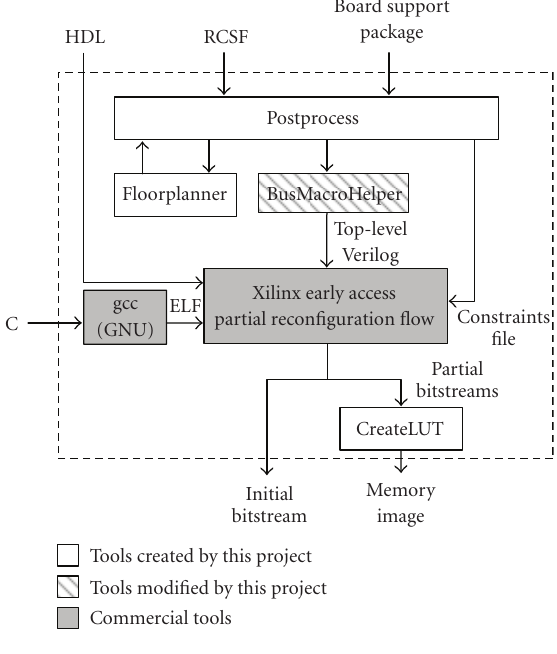
Figure 4: Backend tool